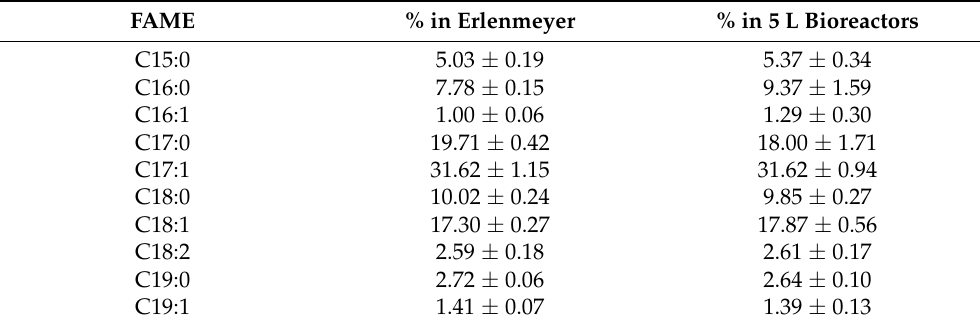
Table 7. Fatty acid composition of lipids extracted from Y. lipolytica cultures after 96 h fermentation in Erlenmeyer flasks and in 5 L bioreactors. Culture conditions were those provided by the design of experiment approach: (sucrose) = 52.4 g/L, (glycerol) = 26.9 g/L, (sodium acetate) = 10.4 g/L, (sodium propionate) = 5 g/L, and (yeast extract) = 4 g/L.